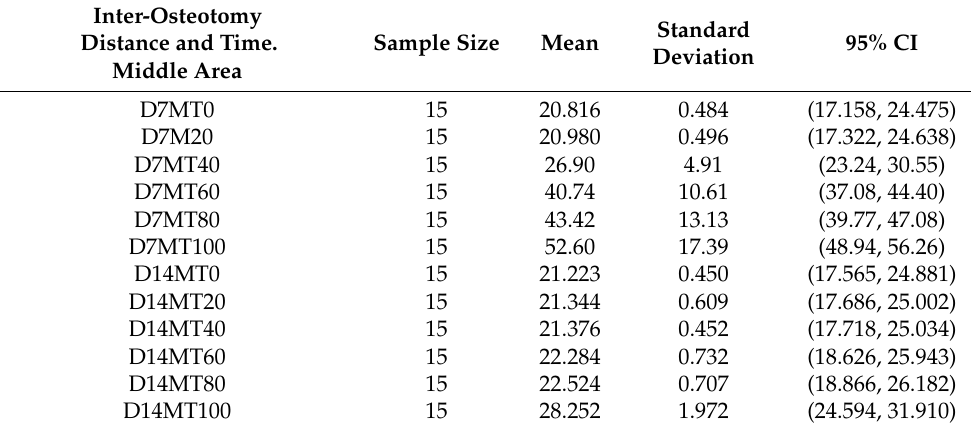
Table 2. Descriptive statistics of inter-implant bed temperature at distances of 7 mm and 14 mm in the middle area of the dense bone. D = distance, M = middle, T = time (T1 = 20 s, T2 = 40 s, T3 = 60 s, T4 = 80 s, T5 = 100